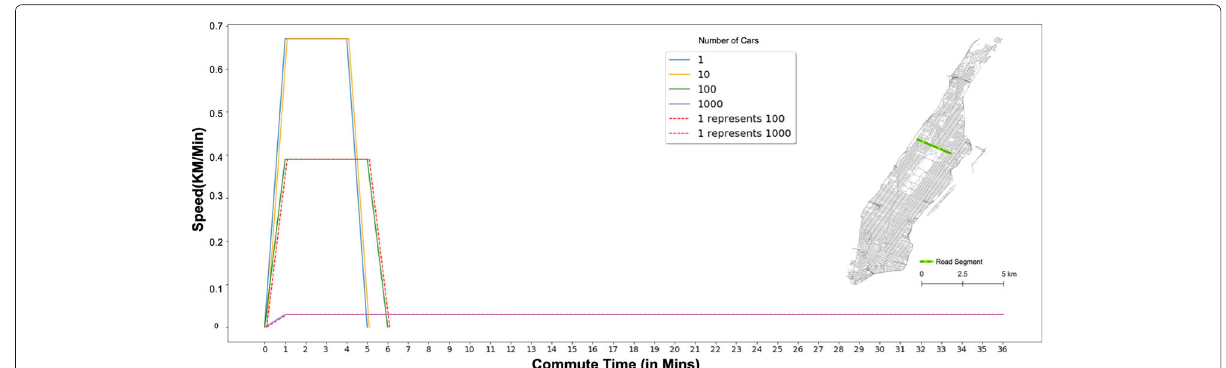
Fig. 10 Model Verification Using Selected Road